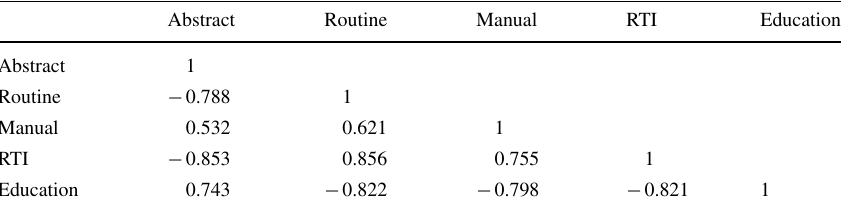
Change in (log) mean wage,